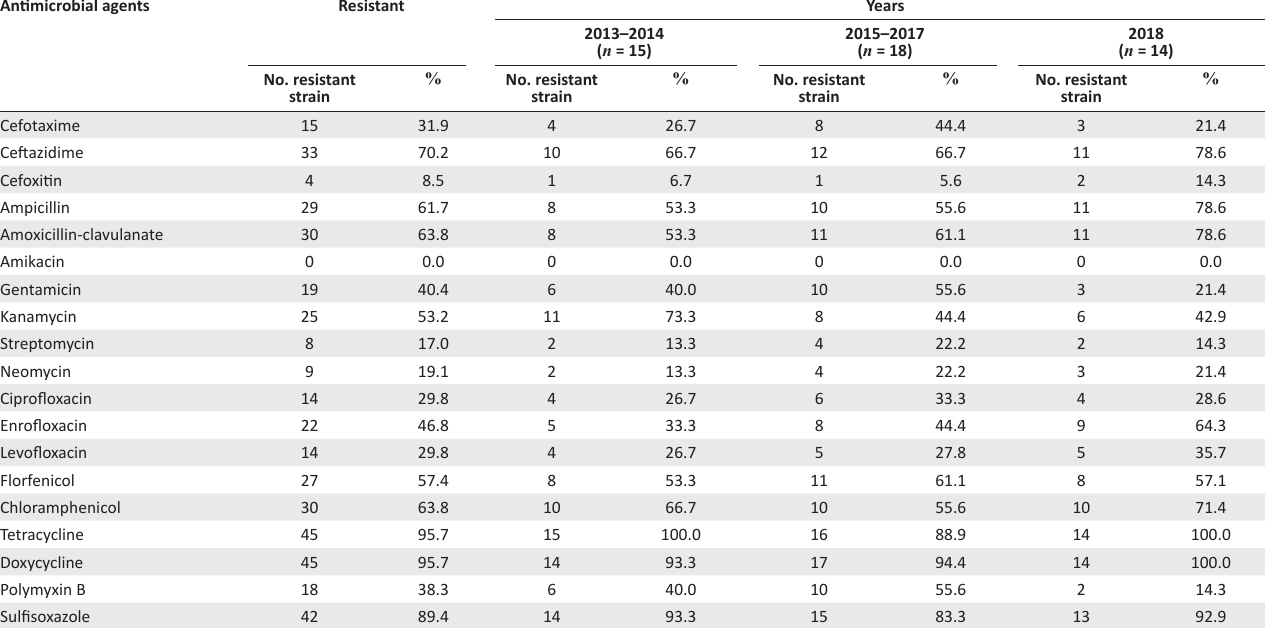
TABLE 2: Antibiotic resistance of 47 Escherichia coli isolates over different years. Antimicrobial agents